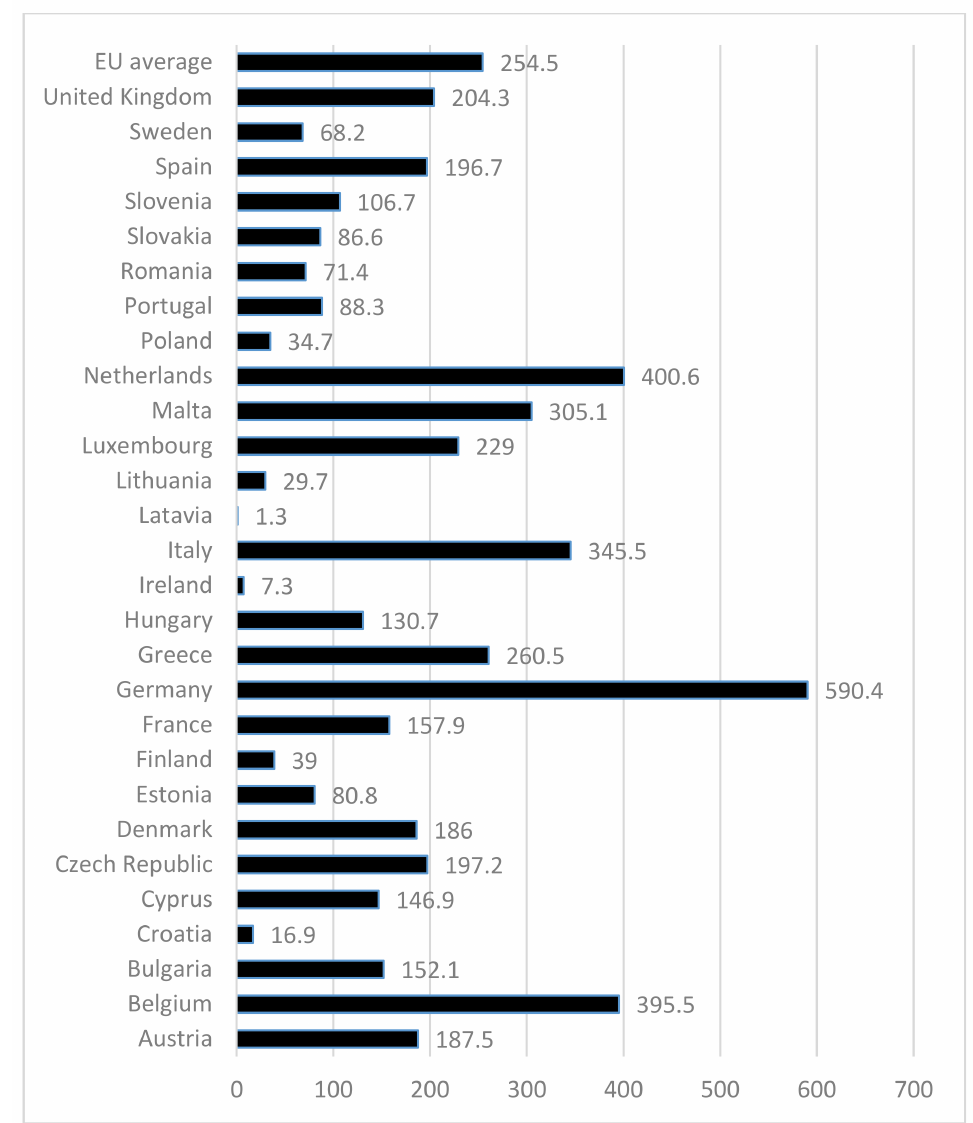
Figure 5. Photovoltaic capacity in European Union countries per inhabitant in 2019 (W/inhabitant). Source: Authors own analysis based on data in